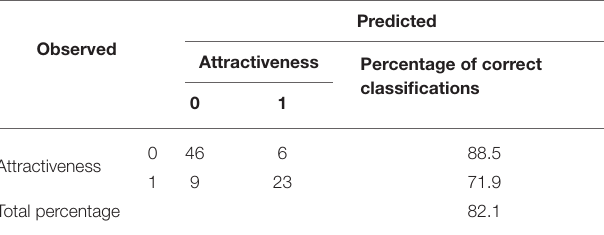
TABLE 9 | Percentage of correct classifications in the training data for the dependent variable “attractiveness”.